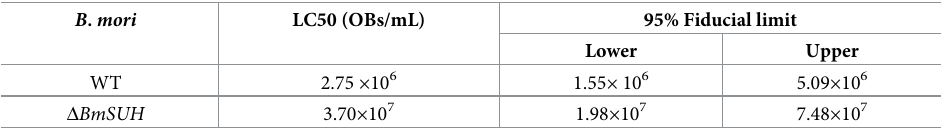
Table 1. LC50 of fourth instar larvae after oral